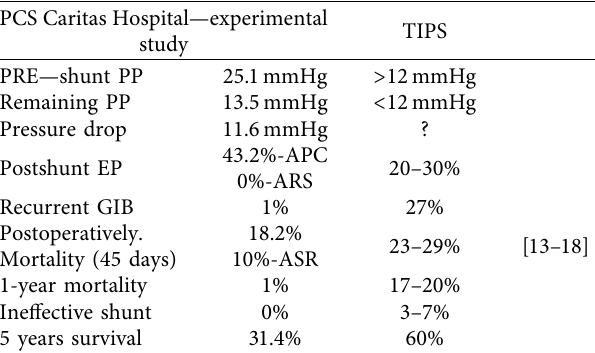
Table 3: Comparison